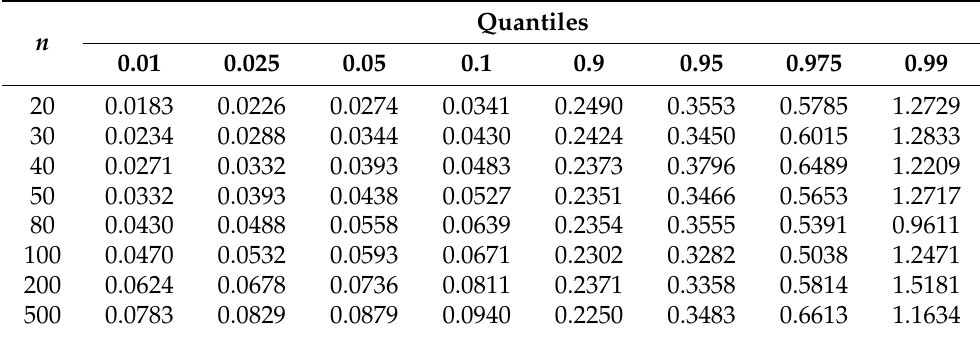
Table 7. Empirical quantiles in the Finite Mixture Model distribution of variances for each sample size ( n ) (based on 5000